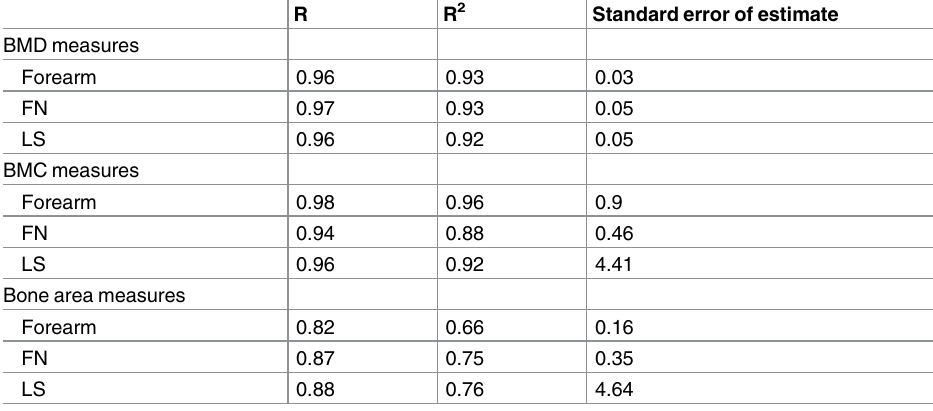
Table 1. Correlation between the two DXA